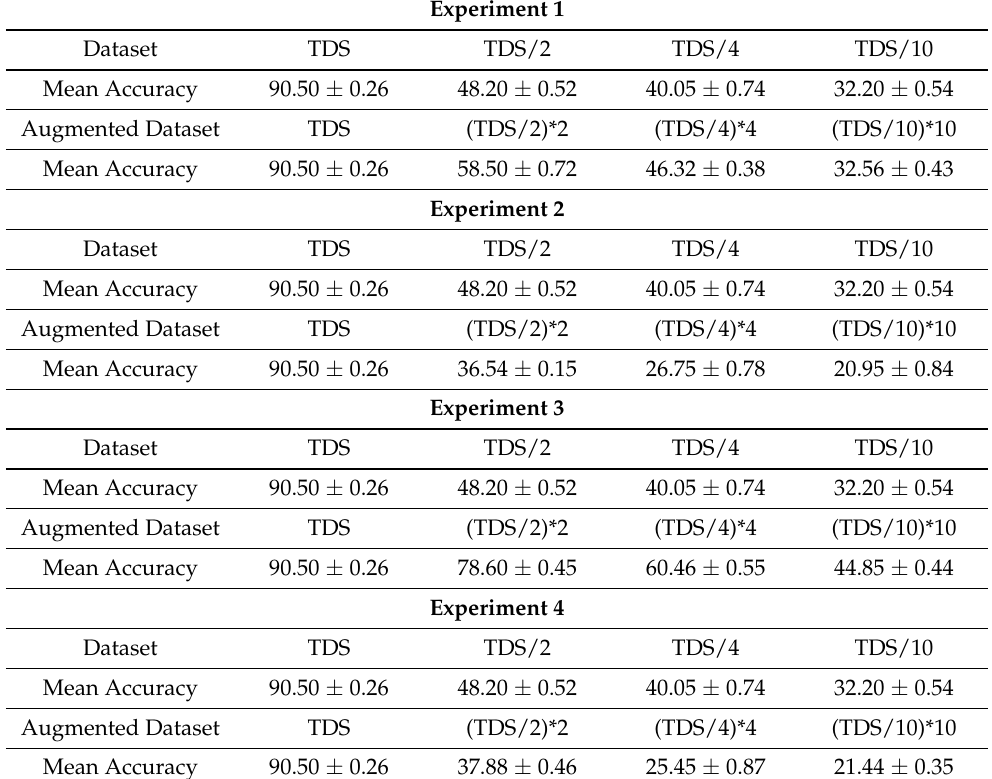
Table 10. The four previously described experiments were repeated for a random α 2, sampled from the new range of [0.0001, 0.001]. Once again experiment-3, where α 2 is added to the non-zero elements in the feature matrix, showed the best